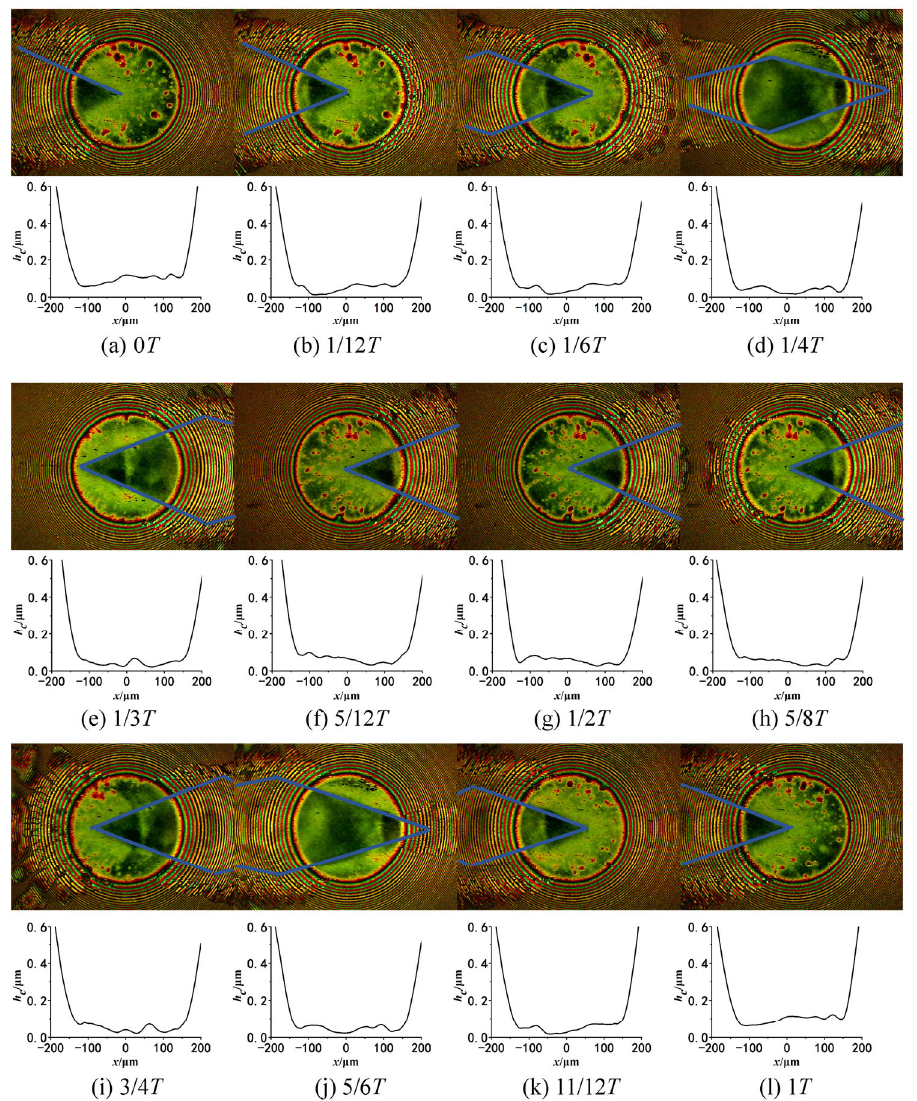
Fig. 12 Interferograms and midsection film thickness during 100th cycle under pure rolling reciprocating motion ( v max = 0.01 m/s, w = 50 N, T = 0.5 s, L = 1.25